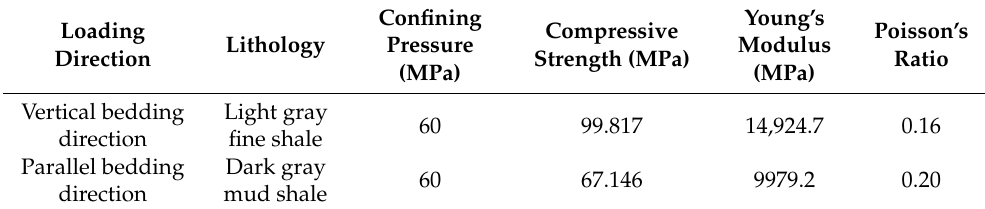
Table 1. Triaxial stress test results.